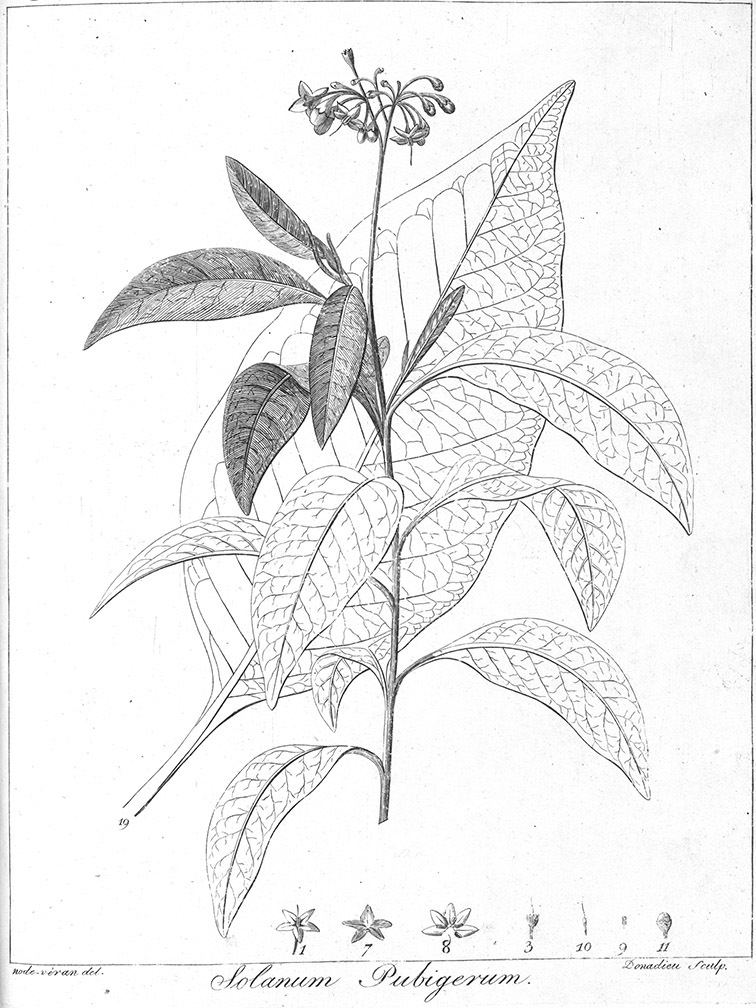
Lectotype of Solanum pubigerum Dunal (Dunal 1813: tab. 6). Reproduced with permission of the Natural History Museum Botany Library.